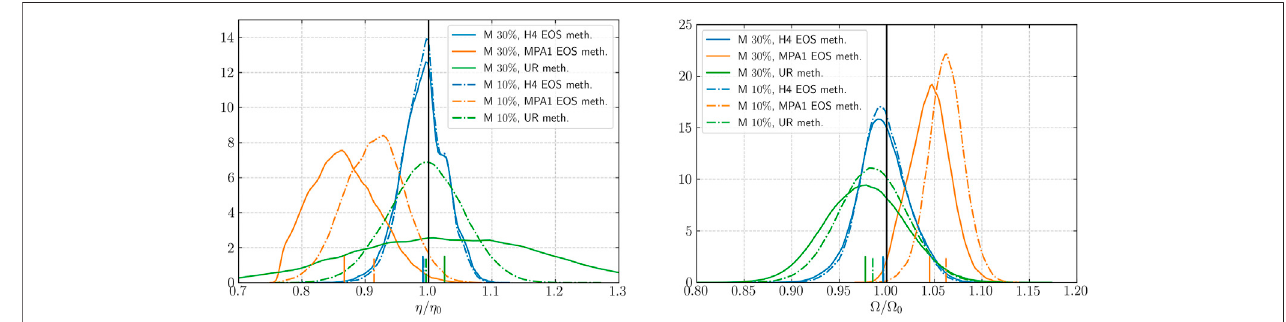
FIGURE8| Hereweshowtheposteriordistributions oftherotationrate Ω (toppanel) andeffectivecompactness η (bottompanel) normalized totheinjected H4 values ( Ω 0 , η 0 ).Posteriors are obtained by using the EoS method with H4 EoS (blue), the MPA1 EoS (orange), as well as the universal relation method (green). Solid lines correspond to 30% relative error on the prior mass M and dashed lines to 10%. We indicate each mean of the posteriors as vertical lines. The f -mode relative error is assumed to be 3%. Figure taken from Völkel et al. (2021) with permission by